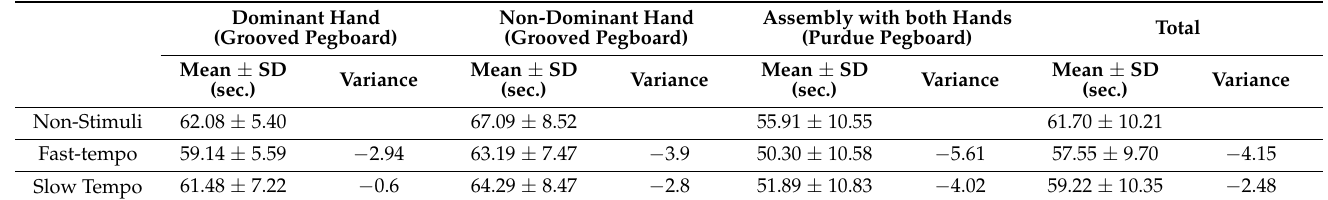
Table 3. Differences in hand dexterity according to auditory